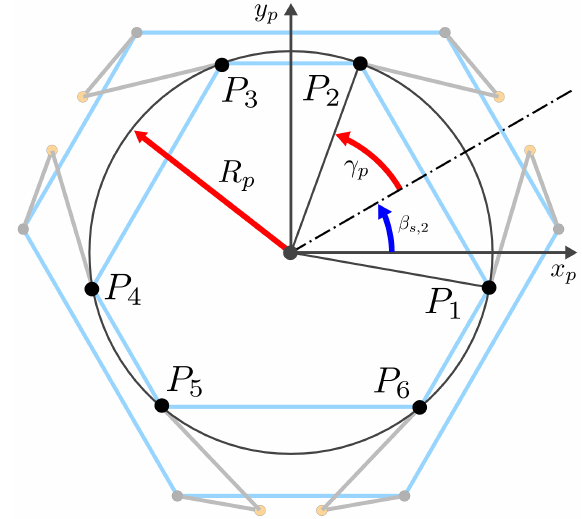
Figure 6. Geometric parameters of the mechanism’s